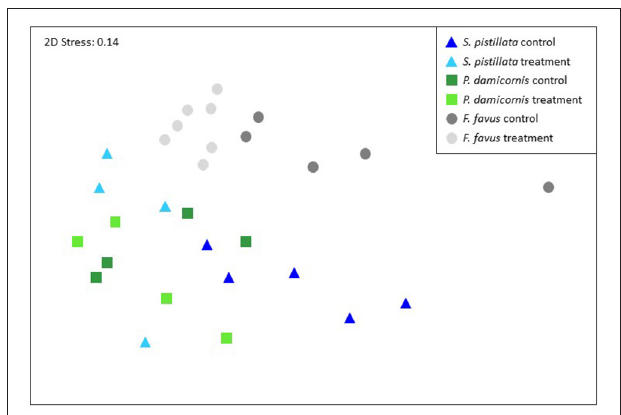
FIGURE 5 | Non-parametric multi-dimensional scaling ordination using the physiological and isotopic variables from 29 of the 31 corals. Two corals were not included because they did not have complete isotope data sets. The NMDS plots and corresponding ANOSIMS patterns were similar when build from just the physiology data (all 31 corals) or just the isotopic data (29 corals). Corresponding ANOSIMs results are given in Tables 4, 5 .